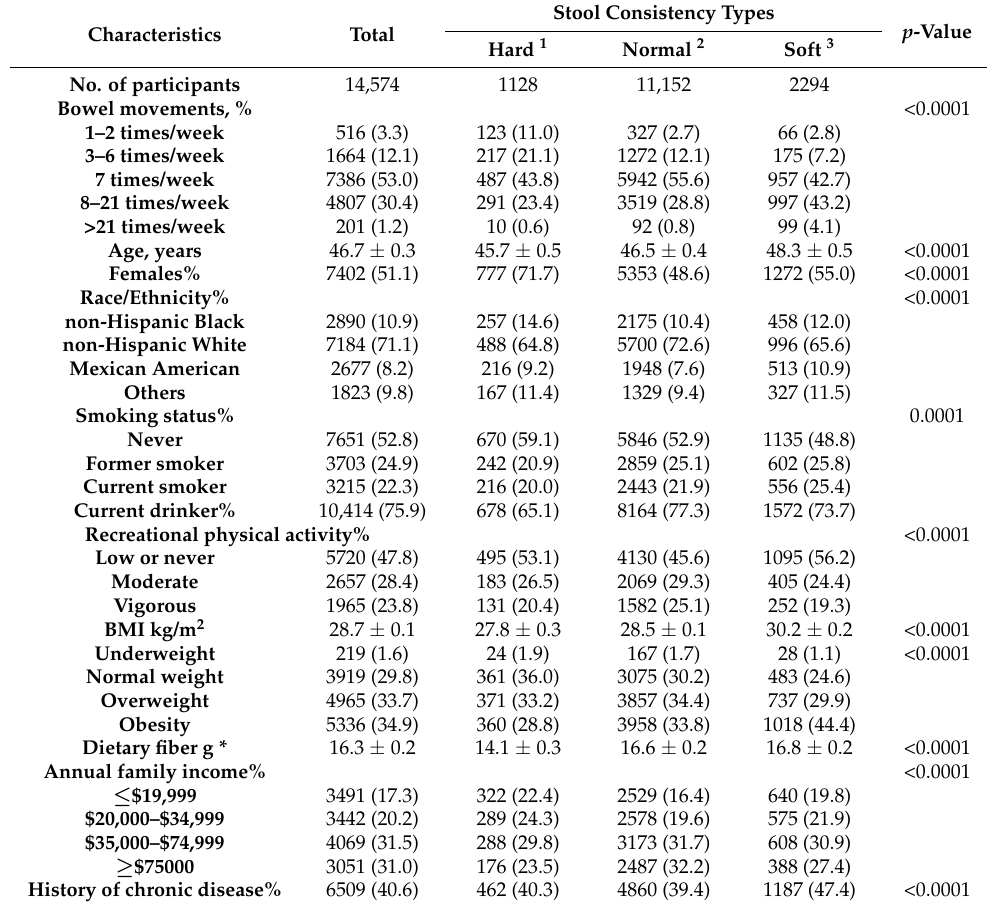
Table 1. Baseline characteristics by stool types among 14,574 participants from NHANES 2005–2010.